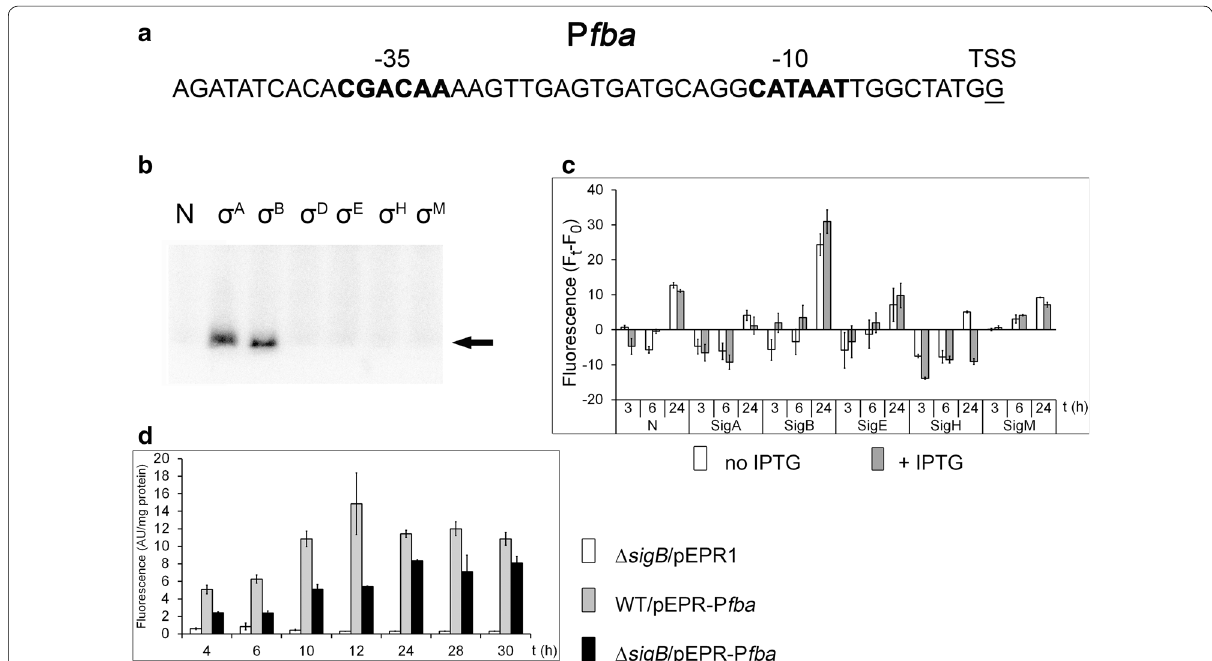
Fig. 7 Assignment of sigma factors to the P fba promoter. a Sequence of the P fba promoter (Ehira et al. 2008). b In vitro transcription with P fba as a template. Individual sigma factors associated with RNAP are shown at the top . The specific transcripts are indicated with an arrow . c P fba promoter activity determined with the two-plasmid system in C. glutamicum WT (with the sig -constructs in the expression vector pEKEx3) by measuring the fluorescence intensity of the Gfpuv reporter. F t F 0 is the difference between the fluorescence at the sampling time (3, 6, 24 h) and the fluores- − cence at time 0 (before sigma gene induction). The sigma factors whose genes were overexpressed are indicated at the bottom . IPTG was added at time 0. d Activity of P fba in C. glutamicum WT and Δ sigB . C. glutamicum Δ sigB with empty vector pEPR1 served as a control. The SDs of three measurements are depicted as error